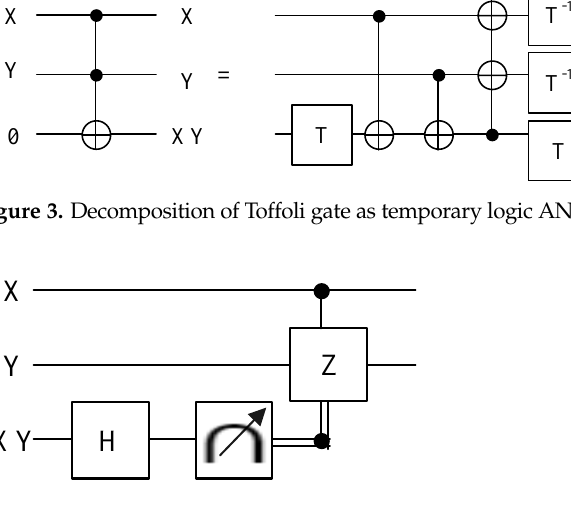
Figure 4. Uncomputation circuit of temporary logic AND with T-count = 0 [10]. Table 1. Clifford+T